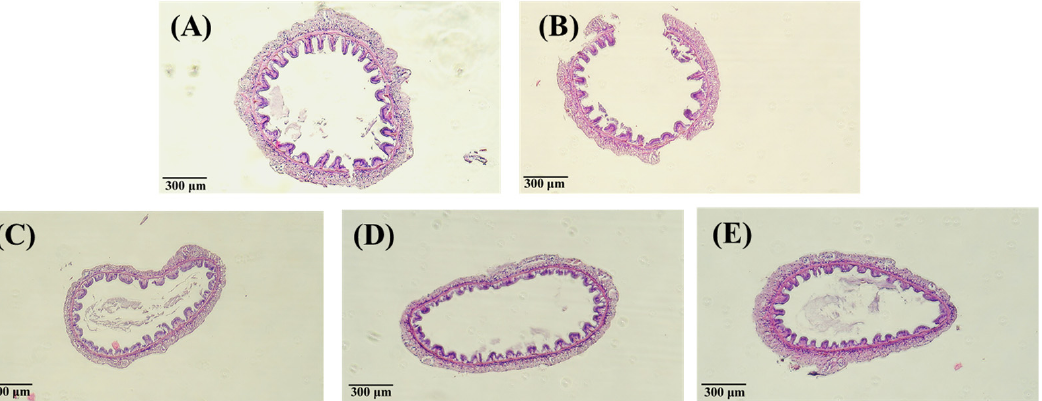
Figure 7. Inverted micrographs of H&E-stained intestine of white shrimp that containing ( A ) control at 0 h; ( B ) control at 240 h; ( C ) injection 50 μ g (g shrimp) − 1 PNWE at 240 h; ( D ) injection 100 μ g (g shrimp) − 1